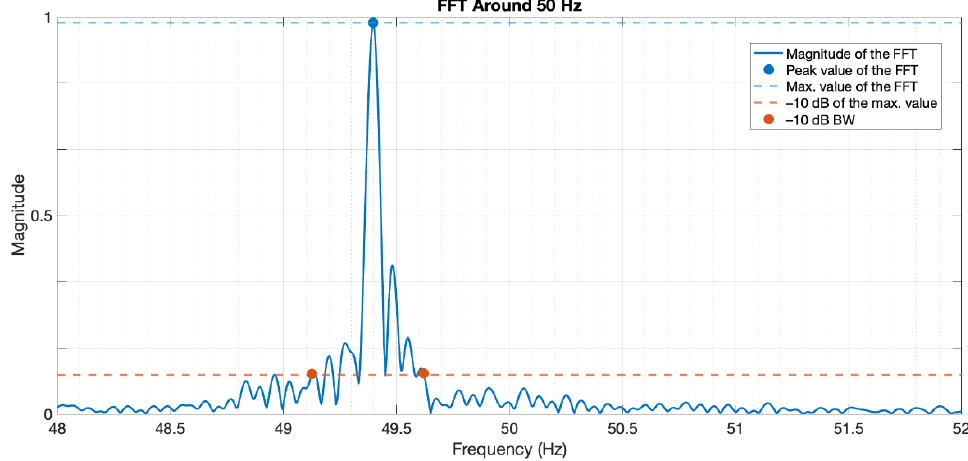
Figure 4. 50 Hz centred FFT of the RPi-generated square wave.